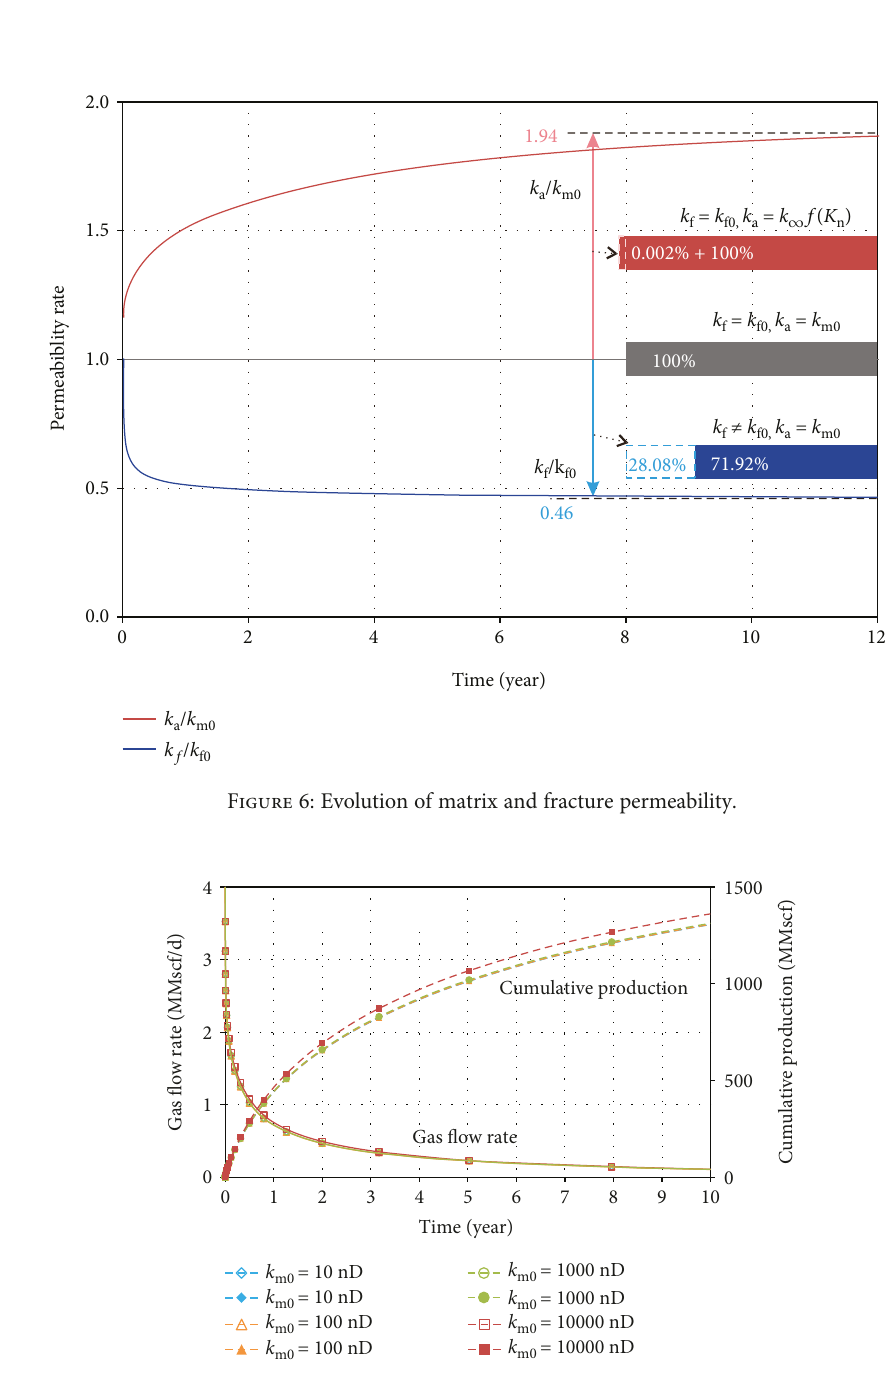
Figure 7: Impact of matrix permeability on gas